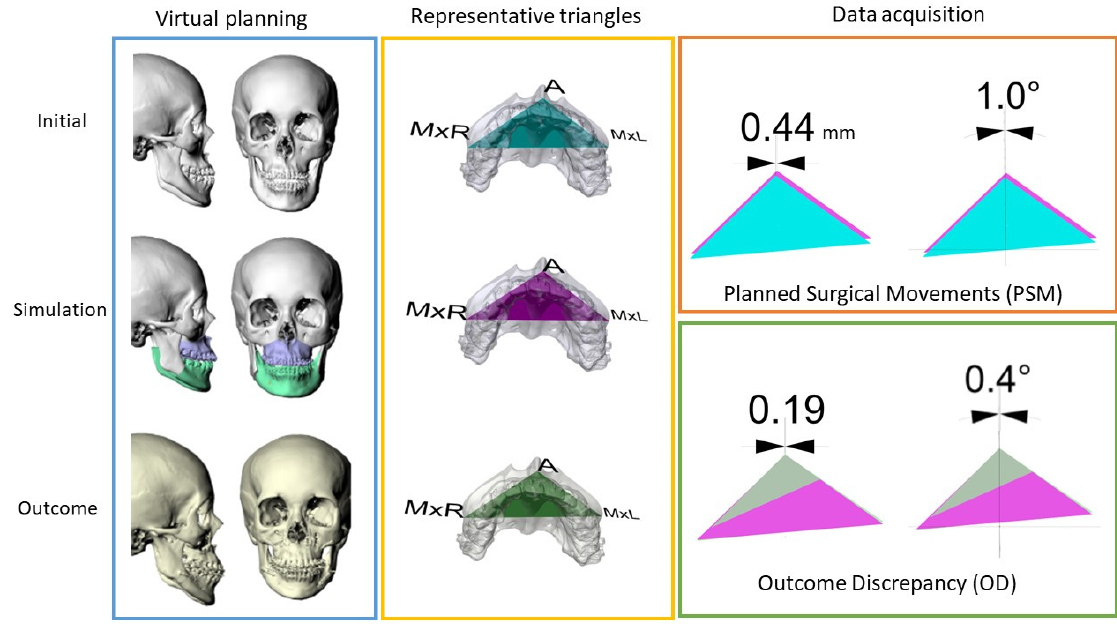
Figure 3. The illustration of the processing procedures, including virtual planning and outcome assessments: A representative triangle was incorporated into the maxilla and transferred into dif- ferent stages by registering it at the area of the posterior nasal spine. The representative triangle at the simulation stage (pink) served as the reference plane. The planned surgical movements were calculated by overlapping the initial triangle (blue) onto the reference plane. On the other hand, the outcome discrepancy was measured by the differences between the outcome triangle (green) and the simulation